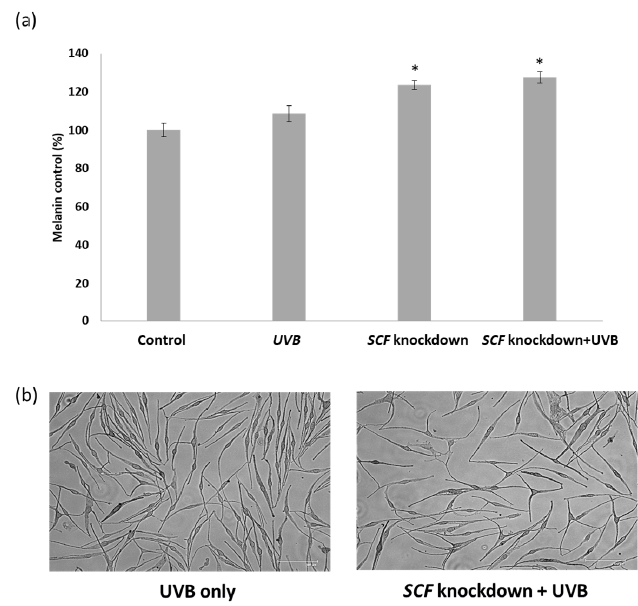
Figure 4. ( a ) The melanin content in melanocytes after being treated with conditioned medium from fibroblast cells for 24 h; ( b ) The morphology of melanocytes was altered (bar = 125 μ m). Red arrows showed the melanocytes with dendricity shape morphology. The data are presented as means ± SD; n = 3, * p < 0.05.